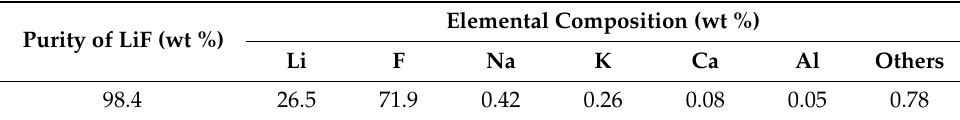
Table 1. Purity of LiF.